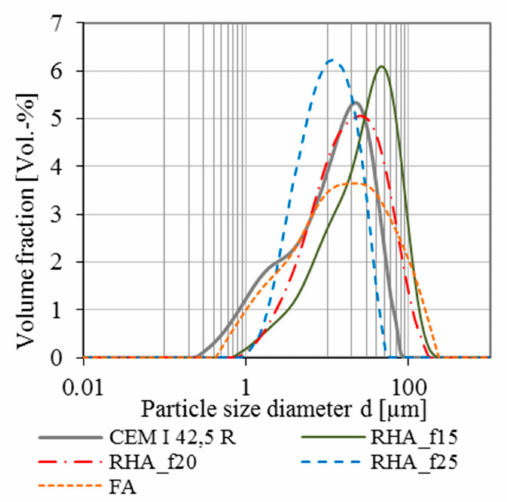
Figure 4. Particle size distribution of CEM I 42.5 R, RHA_f15; RHA_f20, RHA_f25 and fly